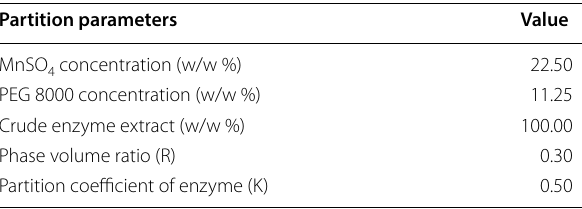
Crude enzyme was subjected to each purification methods separately (Single Step Purification). Purification fold with respect to the crude enzyme. The respective enzyme load in each purification technique was mentioned in methodology